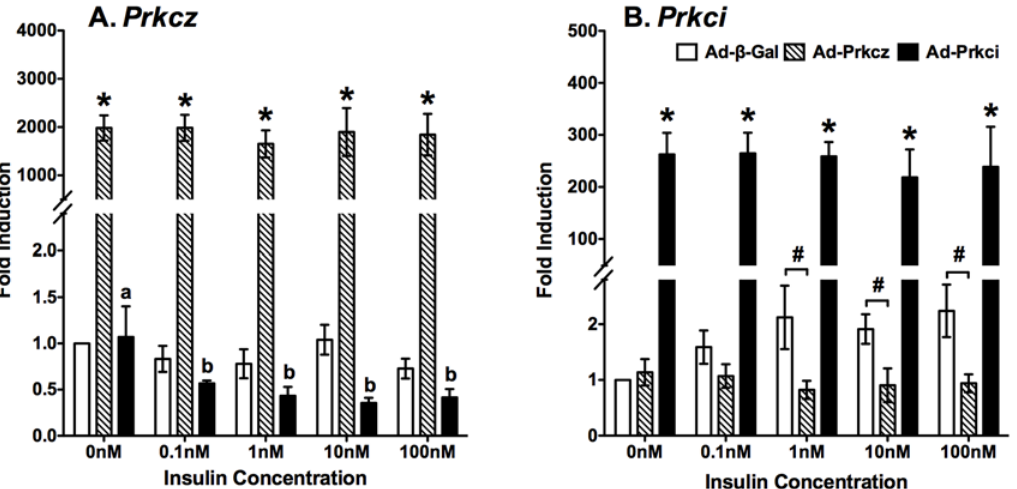
Fig 3. Overexpression of PKC ζ and PKC ι / λ in primary hepatocytes of ZL rats. Primary hepatocytes of ZL rats fed chow for 8 weeks were isolated and seeded onto dishes as described in the Materials and Methods. Purified Ad- β -gal, Ad-Prkcz and Ad-Prkci were added in medium A during the overnight pretreatment period to allow the overexpression of β -GAL, PKC ζ and PKC ι / λ , respectively. The primary hepatocytes were then incubated in fresh medium A with increasing concentrations of insulin (0 nM to 100 nM) for 6 hours before total RNA extraction. Total RNA was extracted, and then subjected to real-time PCR analysis. The data were expressed as fold induction. The gene transcript levels from Ad- β -gal infected primary hepatocytes without insulin treatment were arbitrarily set to 1. (A) The mRNA levels of Prkcz in the ZL primary hepatocytes overexpressing β -GAL, PKC ζ and PKC ι / λ in response to treatments of increasing concentrations of insulin (mean ± SEM; n = 4; all p < 0.05; a > b for comparing insulin treatment groups in hepatocytes overexpressing PKC ζ using one-way ANOVA; * for comparing fold inductions among three groups at indicated treatments using one-way ANOVA). (B) The mRNA levels of Prkci in the ZL primary hepatocytes (n = 4) overexpressing β -GAL, PKC ζ and PKC ι / λ in response to treatments of increasing concentrations of insulin (mean ± SEM; n = 4; all p < 0.05; * and # for comparing fold inductions among three groups at indicated treatments using one-way ANOVA).